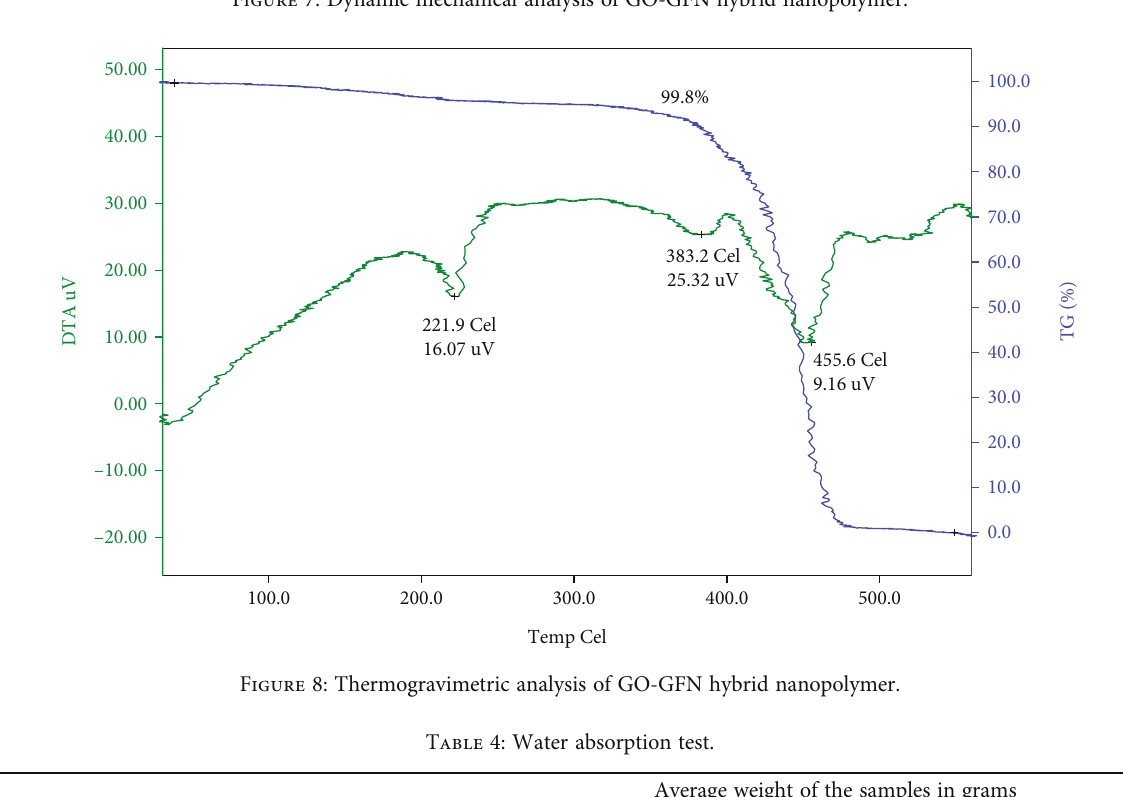
Figure 7: Dynamic mechanical analysis of GO-GFN hybrid nanopolymer.